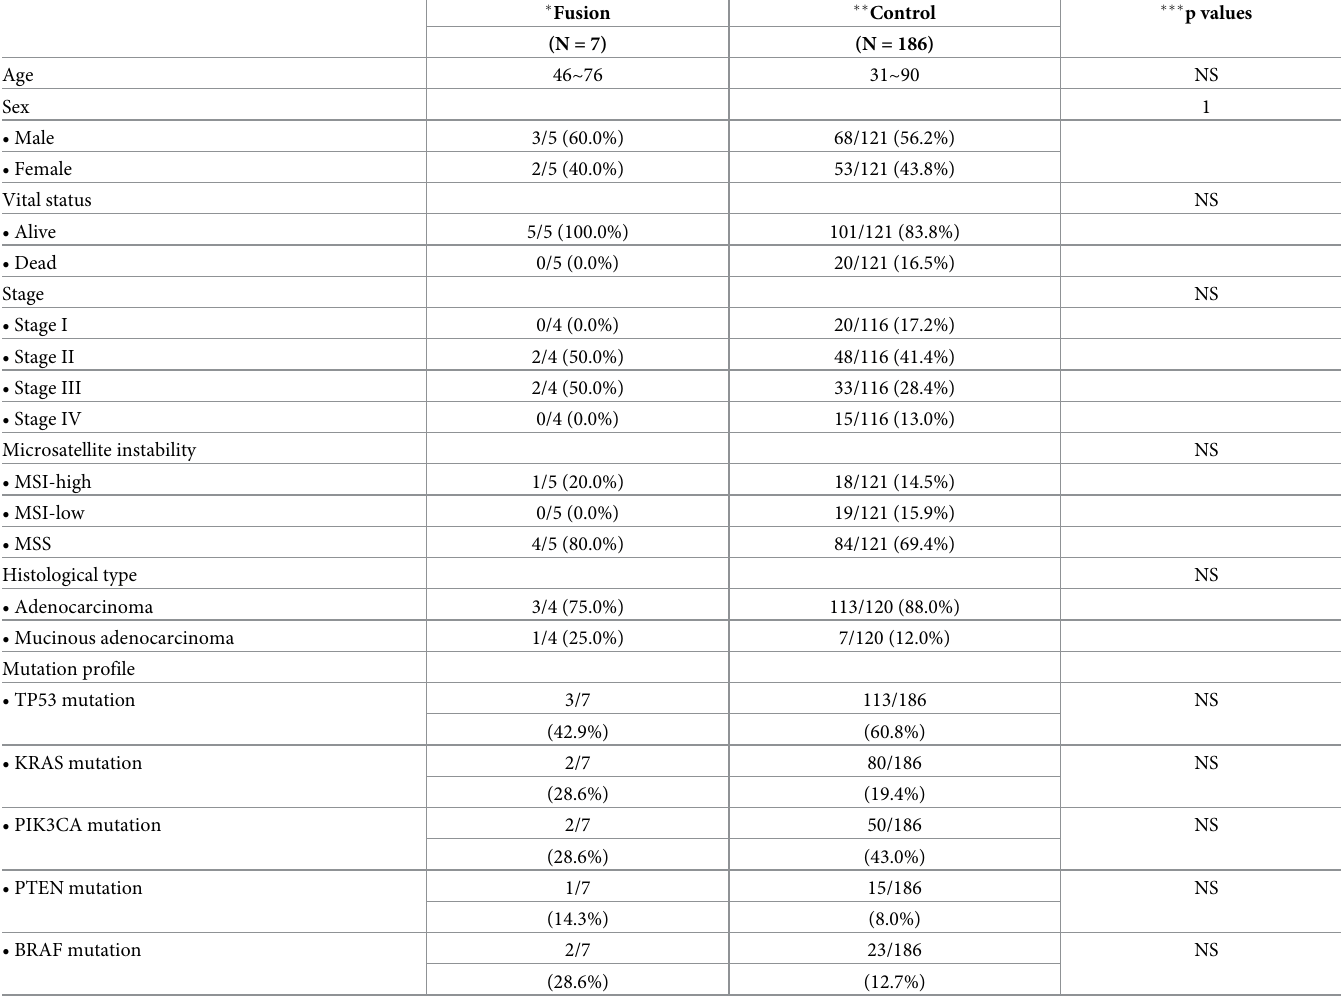
� Samples harboring PTPRK-RSPO3